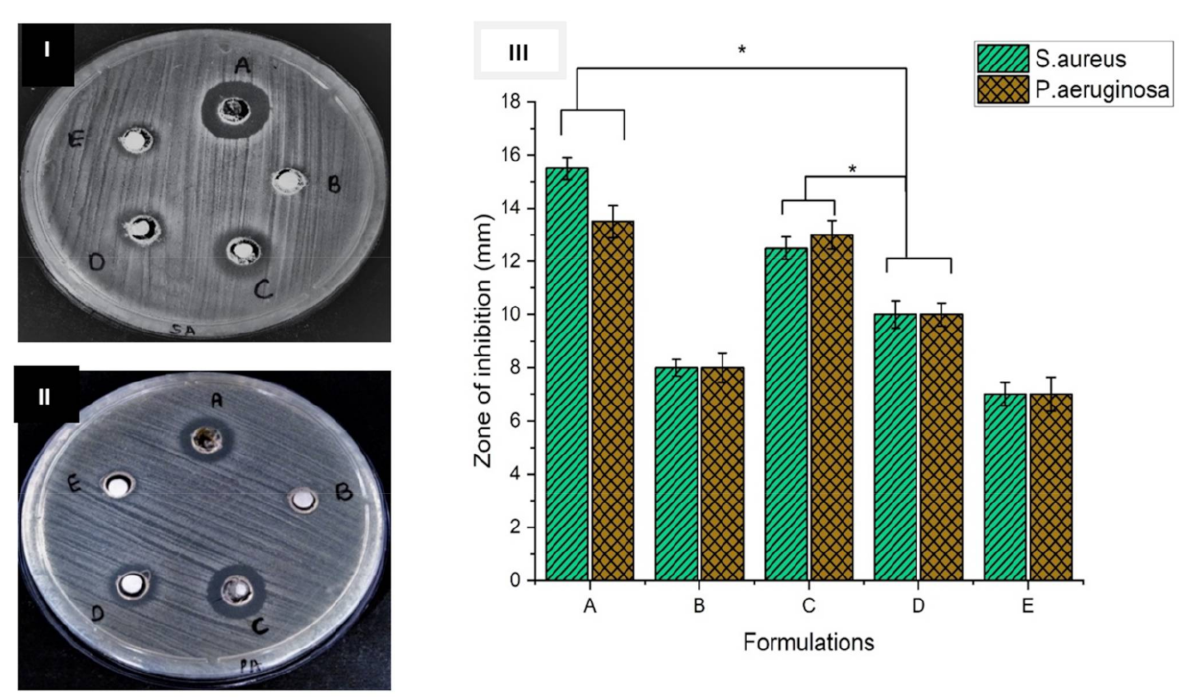
Figure 6. Inhibition zones of the nanofiber discs: ( A ) FA-SS-PCL-NF; ( B ) placebo; ( C ) FA-SS-CA-NF; ( D ): +ve control; ( E ) SS-NF against ( I ) Staphylococcus aureus and ( II ) Pseudomonas aeruginosa. ( III ) Bar graph of disc diffusion assay results. * Significant differences between control and the formulations corresponding to each bacteria.